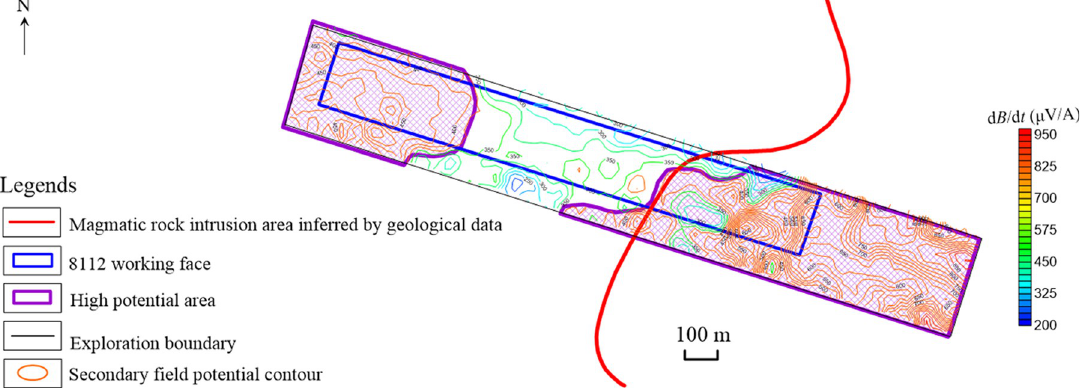
Fig 7. Contour map of the No. 13 channel secondary field